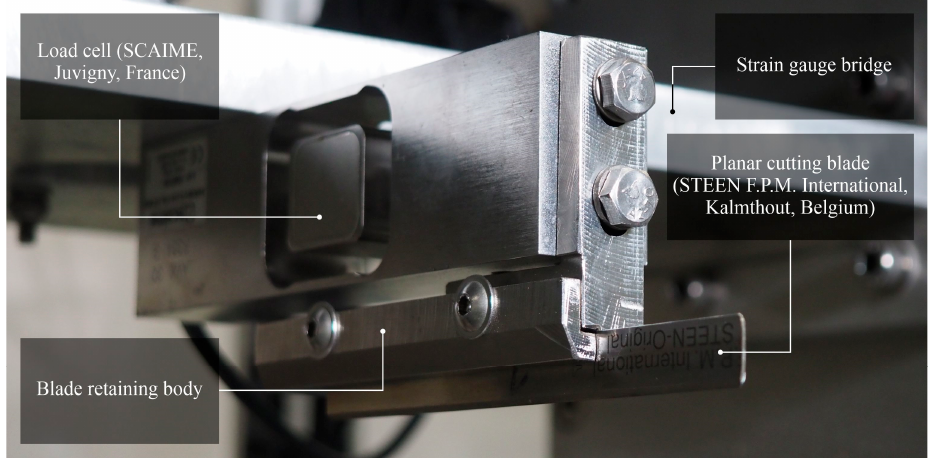
Figure 3. Method of fixing planar technical blade in the holder at the strain gauge bridge. Table 1. Technical parameters of the cutting force measurement station [9].